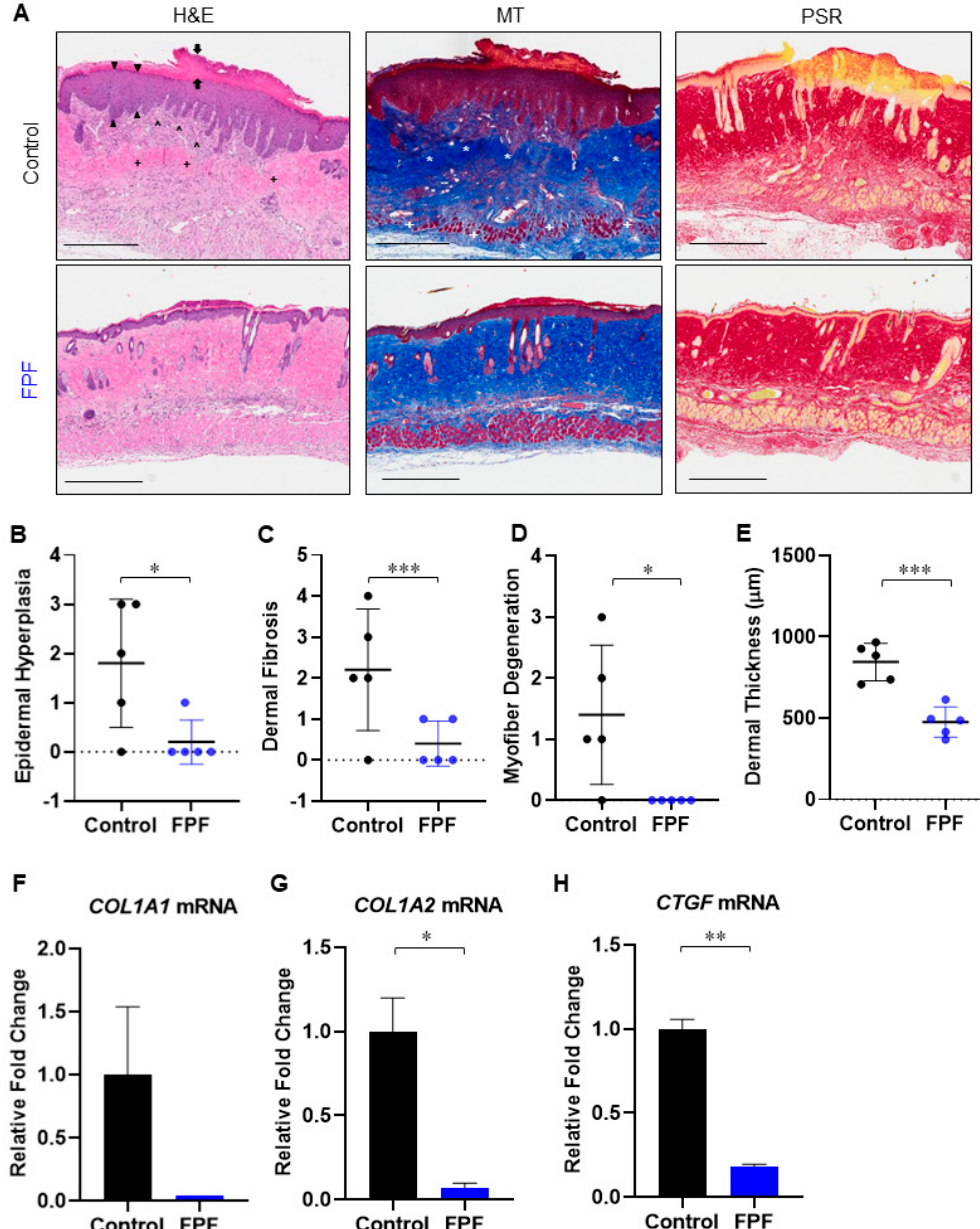
Figure 3. FPF ameliorates the progression of bleomycin-induced dermal fibrosis in aged mice. ( A ) Histological analysis of skin tissue architecture following bleomycin injections in control ( top panels ) and FPF-treated ( bottom panels ) animals. Tissue was collected on Day 21, and tissue sections were stained with H&E ( left panels ), MT ( middle panels ), and PSR ( right panels ). Thickening in both the dermis and epidermis was observed in control mice ( top left panel, black arrows ). Conversely, fibrosis was diminished in FPF-treated skin ( bottom panel ). Arrows = Parakeratosis; Arrow heads = Epidermal hyperplasia; * = Excessive collagen deposition; + = Myofiber / degeneration / atrophy; ˆ = Excessive Inflammatory cell infiltration; + = Dermal fibrosis. Representative images of five animals per group are shown. Scale bars = 500 µ m. Dot plot of histological scoring for ( B ) Epidermal hyperplasia, ( C ) Dermal fibrosis, ( D ) Myofiber degeneration / atrophy, and ( E ) Dermal thickness, where 0 = normal tissue, 1 = minimal, 2 = mild, 3 = moderate, 4 = marked change. N = 5 mice / group. RT 2 qPCR for ( F ) COL1A1 , ( G ) COL1A2 , ( H ) CTGF in control (black bars) and FPF (blue bars)-treated mice. N = 3 mice / group. * p < 0.05, ** p < 0.01, *** p <